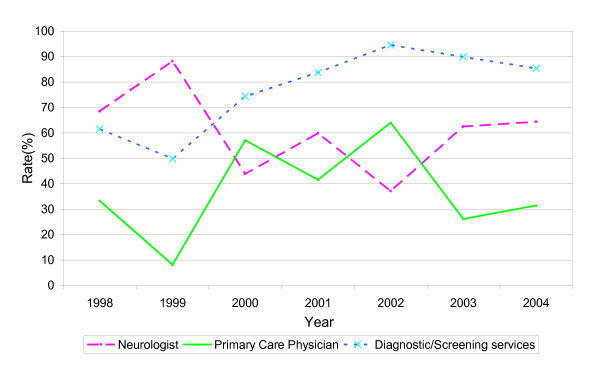
Trends in physician return visits with a diagnosis of MS, NAMCS data, 1998–2004. Y-axis depicts all returning patients with MS diagnosis.